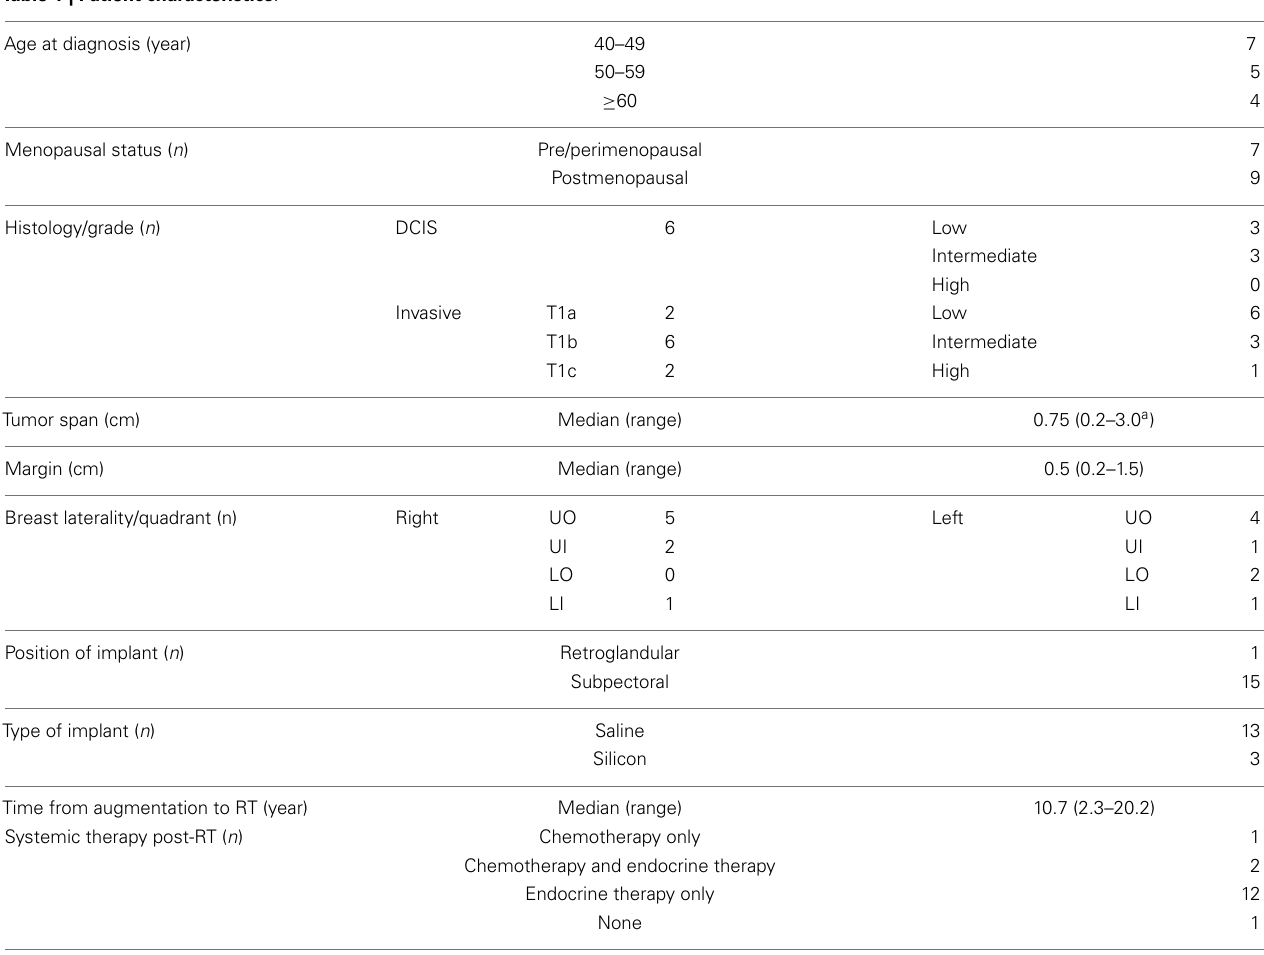
Table 1 | Patient characteristics